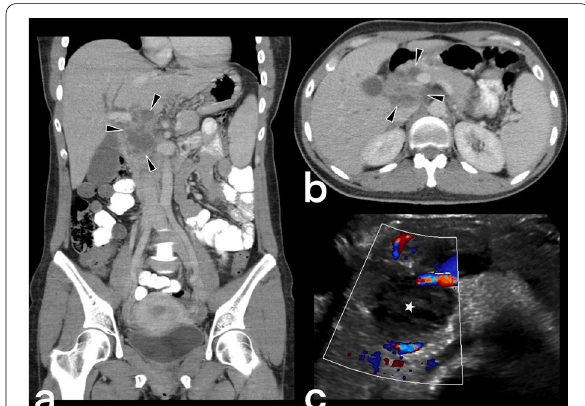
Fig. 32 A 40-year-old female. Contrast-enhancement CT scan ( a , b ) and Doppler ultrasonography ( c ) demonstrated a large heterogeneous cystic-necrotic mass in the head of the